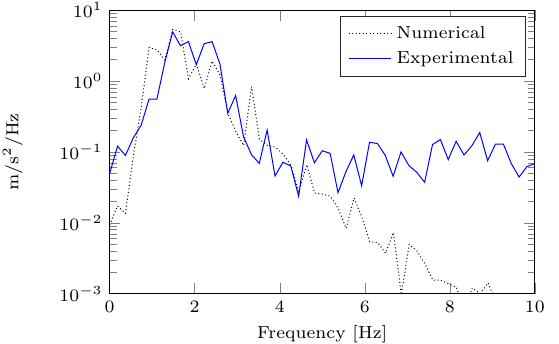
Figure 5. Power spectral density of the numerical and experimental acceleration at the operator’s seat of the tractor with an operative speed v = 6.3 km/h on the rougher